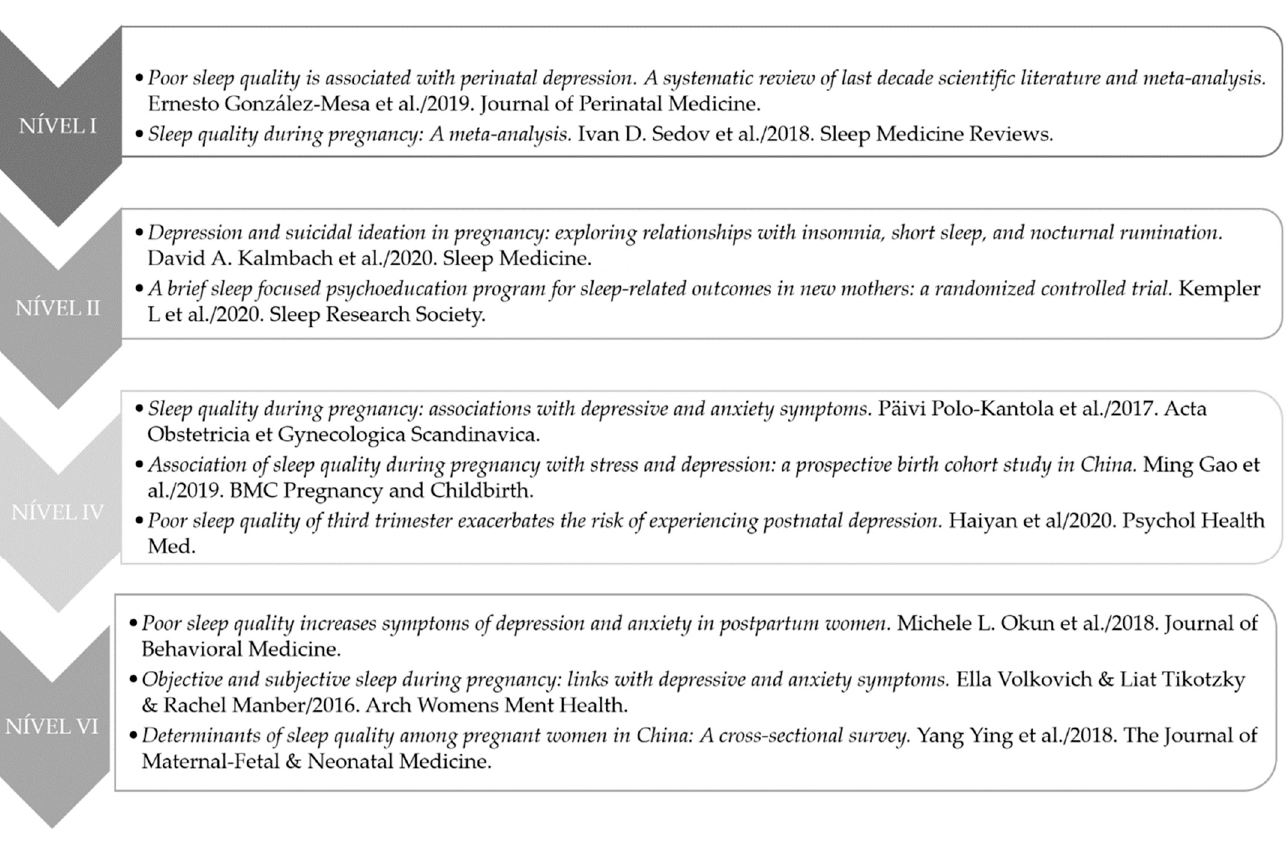
Table 2. Summary of the results of the included studies.